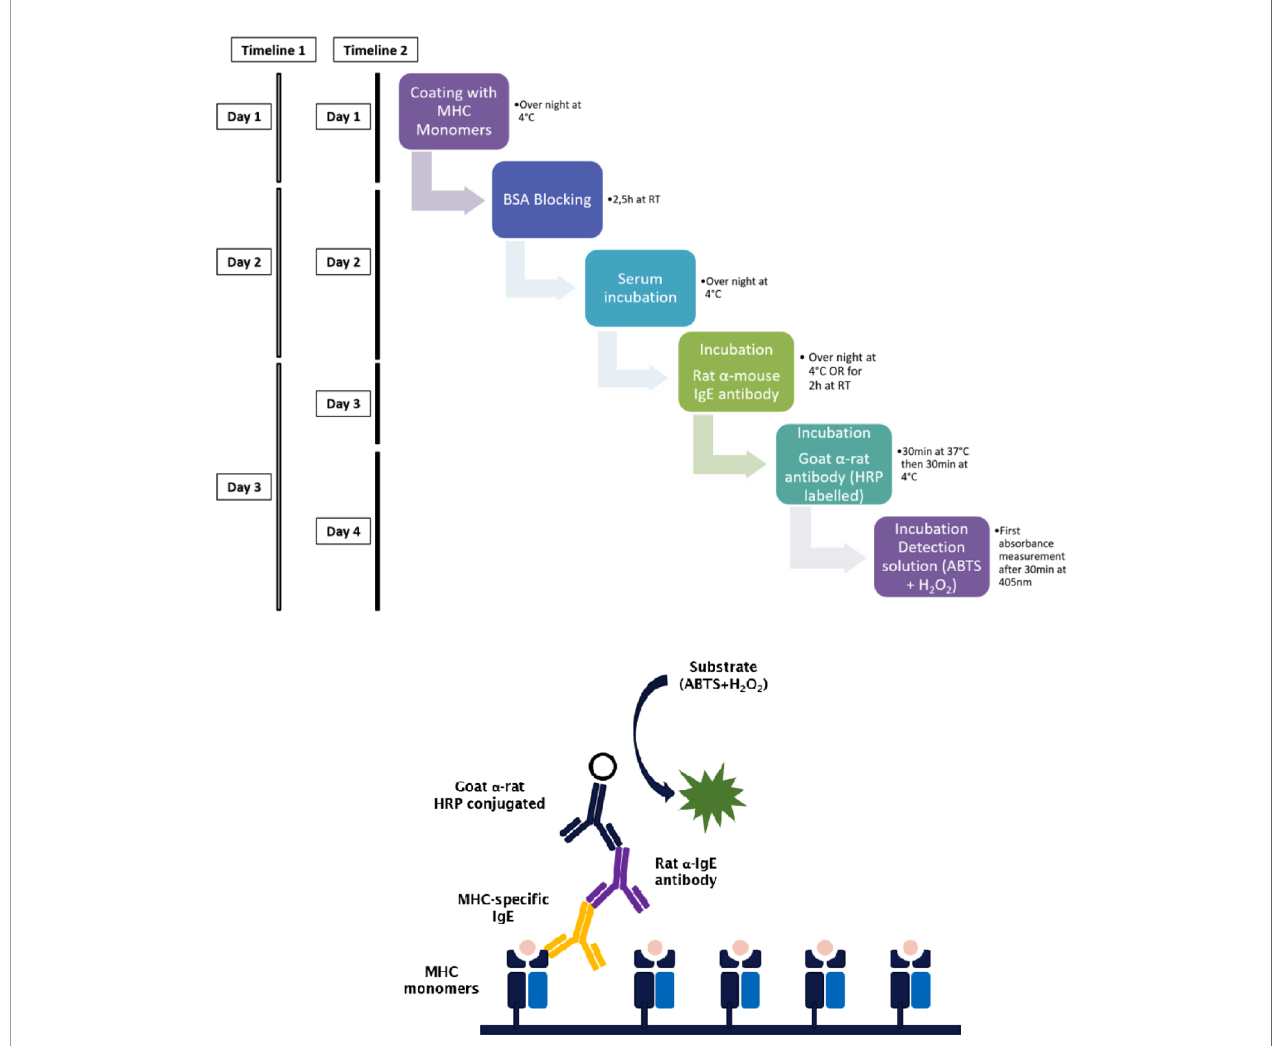
FIGURE 1 | Step by step procedure and schematic representation of the MHC-speci fi c ELISA. Murine MHC monomers are incubated with murine serum to be analyzed for the presence of MHC-speci fi c IgE. MHC-speci fi c antibodies bind to their respective epitope on the monomers and are then detected using a primary antibody. The timeline of the ELISA procedure varies with the incubation time and temperature of the primary antibody. When incubated for 2 h at RT the ELISA takes three days (timeline 1), when incubated at 4°C overnight, the ELISA takes four days (timeline 2). The secondary or detection antibody is conjugated with HRP. Due to the presence of hydrogen peroxide and HRP, ABTS is oxidized to a radical cation. The resulting blue-green reaction product of ABTS can be measured at 405 of the RBL-2H3 cell line. They were incubated with 1% Triton X- 100, which leads to cell death and therefore to a maximum (100%) release of b -hexasominidase ( Equation 1 ). The analytic compound 4-methylumbelliferyl- N -acetyl- b - D -glucosamide (4- MUG; Sigma-Aldrich, St. Louis, MO) is aliquoted beforehand to 10 mM stock solutions in DMSO for storage at − 80°C. For measurements of the b -hexasominidase release of degranulated basophils, 80 μl of 4-MUG stock solution is transferred to 5 ml of citrate buffer (19.2 g 0.1 M citric acid, or sodium citrate, in 1,000 ml ddH 2 O; pH 4.5) and the plate was incubated with this assay solution for 1 h at 37°C. Glycine buffer (15 g Glycine ; 11.7g NaCl in 1,000 ml ddH 2 O; pH 10.7) was used to stop this reaction and the fl uorescence was measured using an In fi nite plate reader (In fi nite F50, TECAN) at l Ex: 360/ l Em: 465 nm ( Figure 2 ).